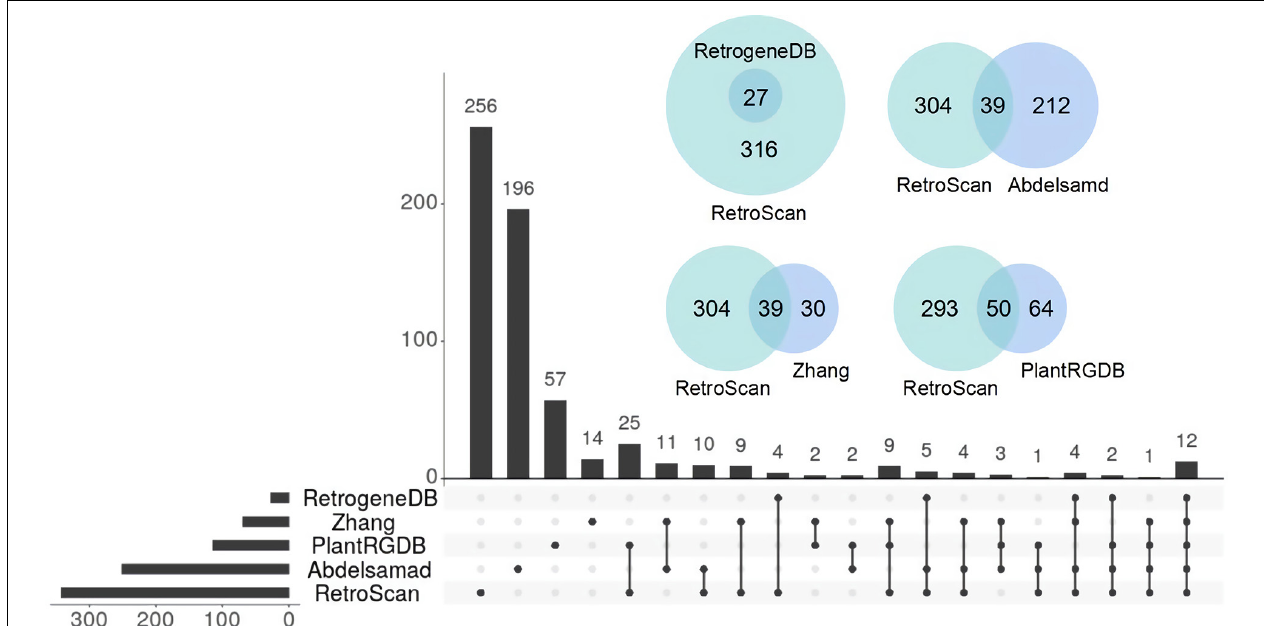
FIGURE 3 | Comparison of Arabidopsis thaliana retrocopies identified by RetroScan and four other methods.